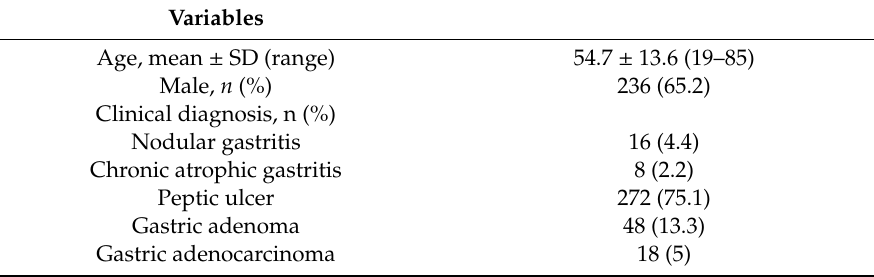
Table 1. Baseline characteristics of patients with tailored therapy ( n =